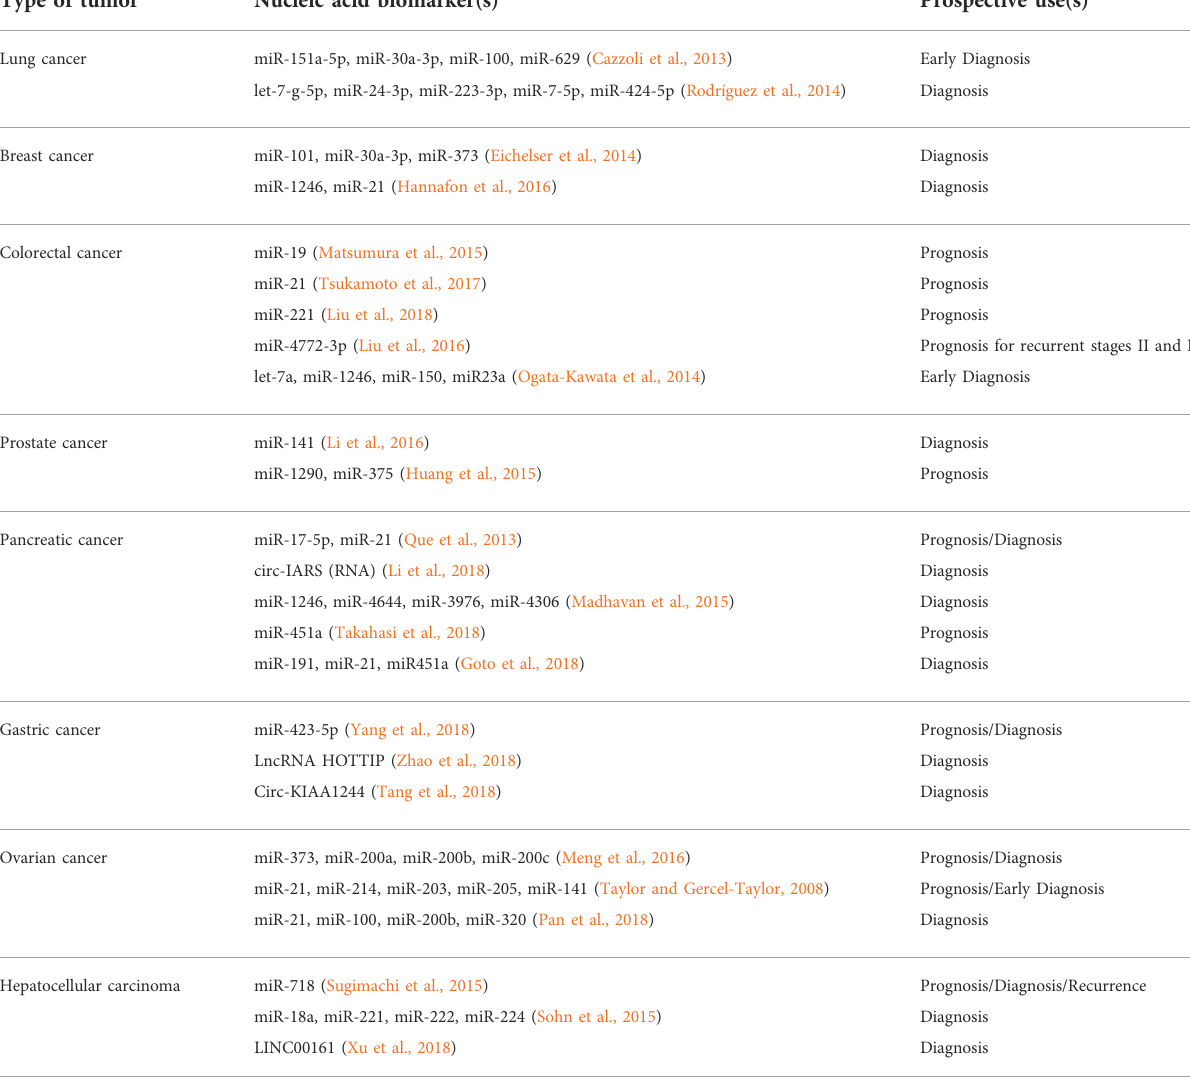
TABLE 2 Exosomal nucleic acids as biomarkers for diagnosing Cancer from serum and